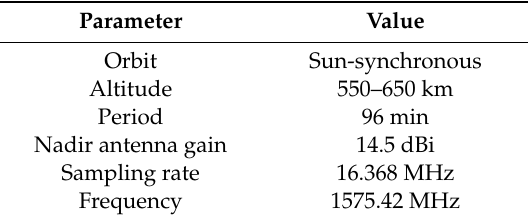
Table 1. Orbital and payload specifications of the TRITON satellite